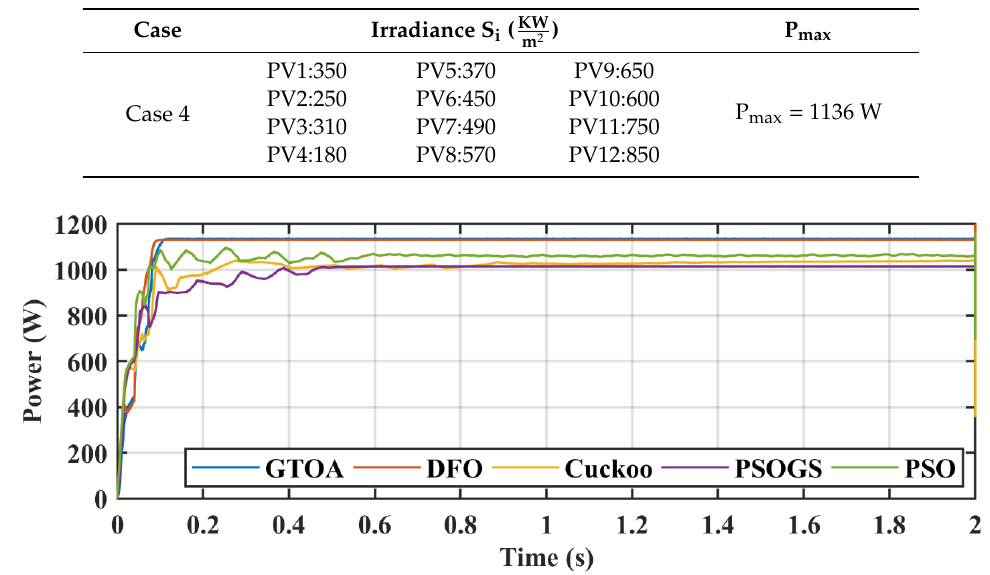
Figure 27. Comparison of power of GTOA.